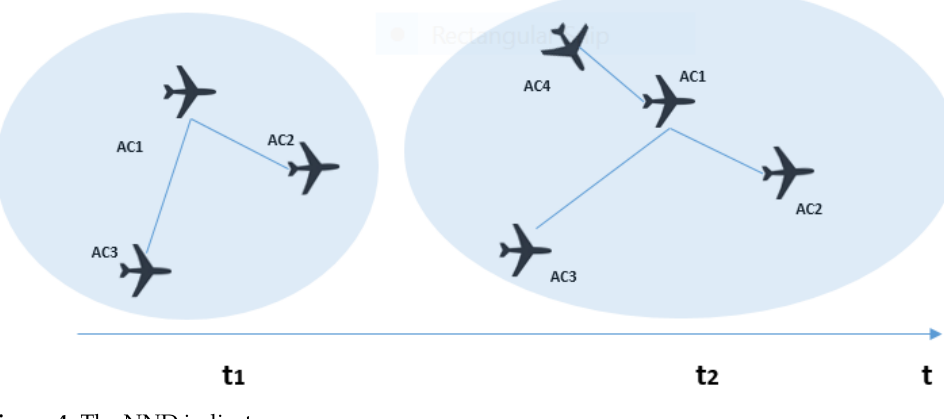
Figure 4. The NND